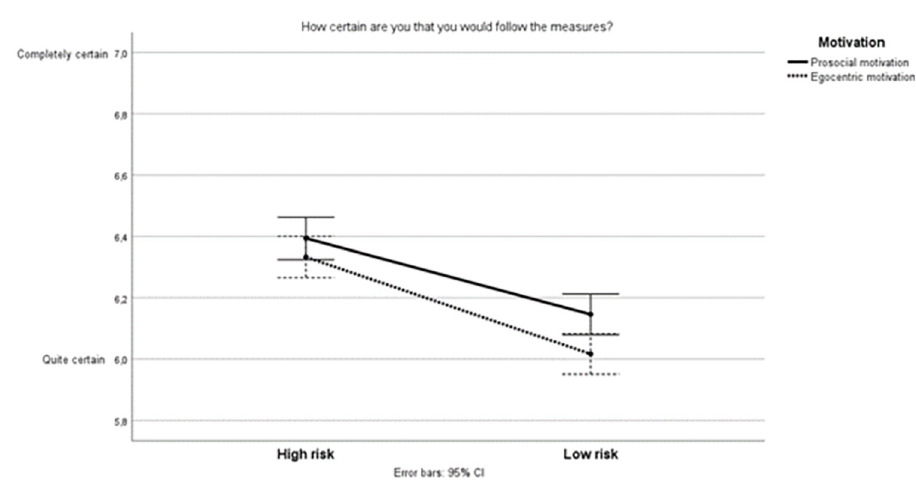
Fig 1. Main effects for high risk and prosocial motivation on